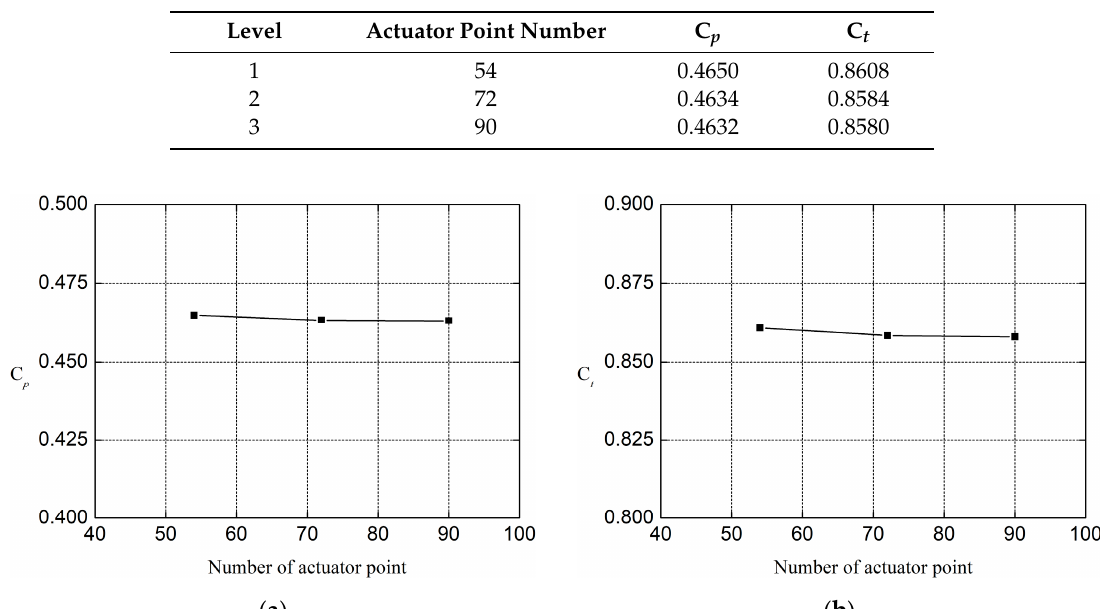
Table 3. Relationship between actuator point number and aerodynamic coefficients.